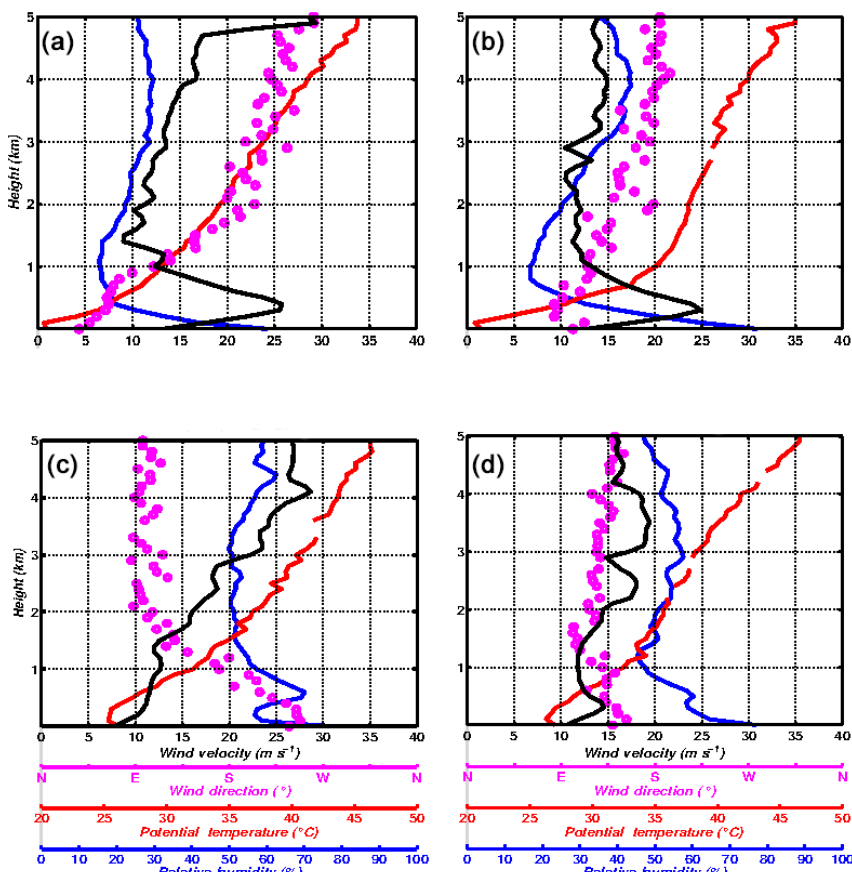
Figure 7. Mean seasonal vertical profiles of wind velocity (black line), wind direction (pink dots), potential temperature (red line), and relative humidity (blue line) at Dakar weather station (14.73 ◦ N, 17.51 ◦ W) for (a) DJF; (b) MAM; (c) JJA; and (d) SON. Observations correspond to weather balloons launched daily at 12:00UTC for years 2012 to